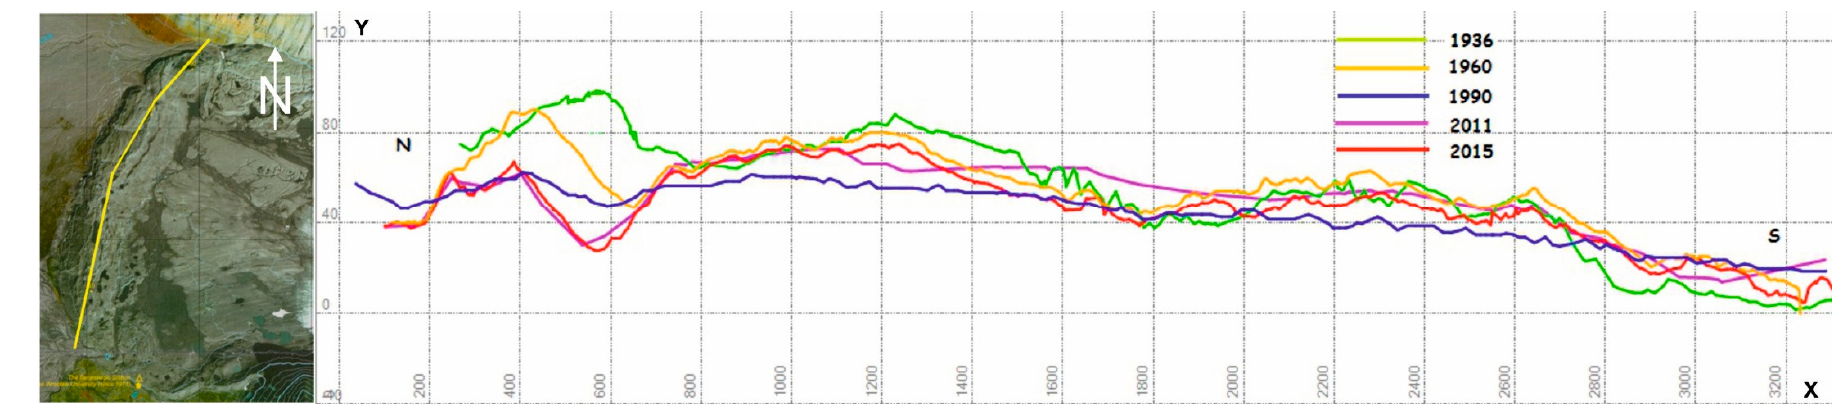
Figure 6. Longitudinal profile of the entire length of the moraine and across each of its calculated surfaces. The Y -axis represents elevation variations [m], the X -axis shows the length of the profile [m].